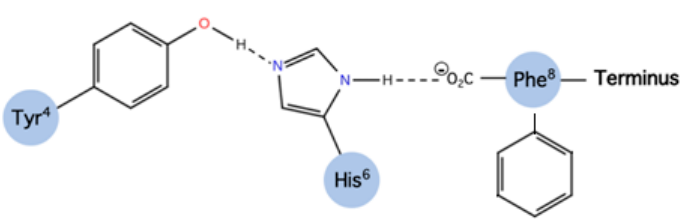
Figure 6. Tyr, His, and Phe aromatic side chains and c-terminal carboxylate are intra connected to create a cyclic compact structure that triggers activity through Tyr hydroxylate.